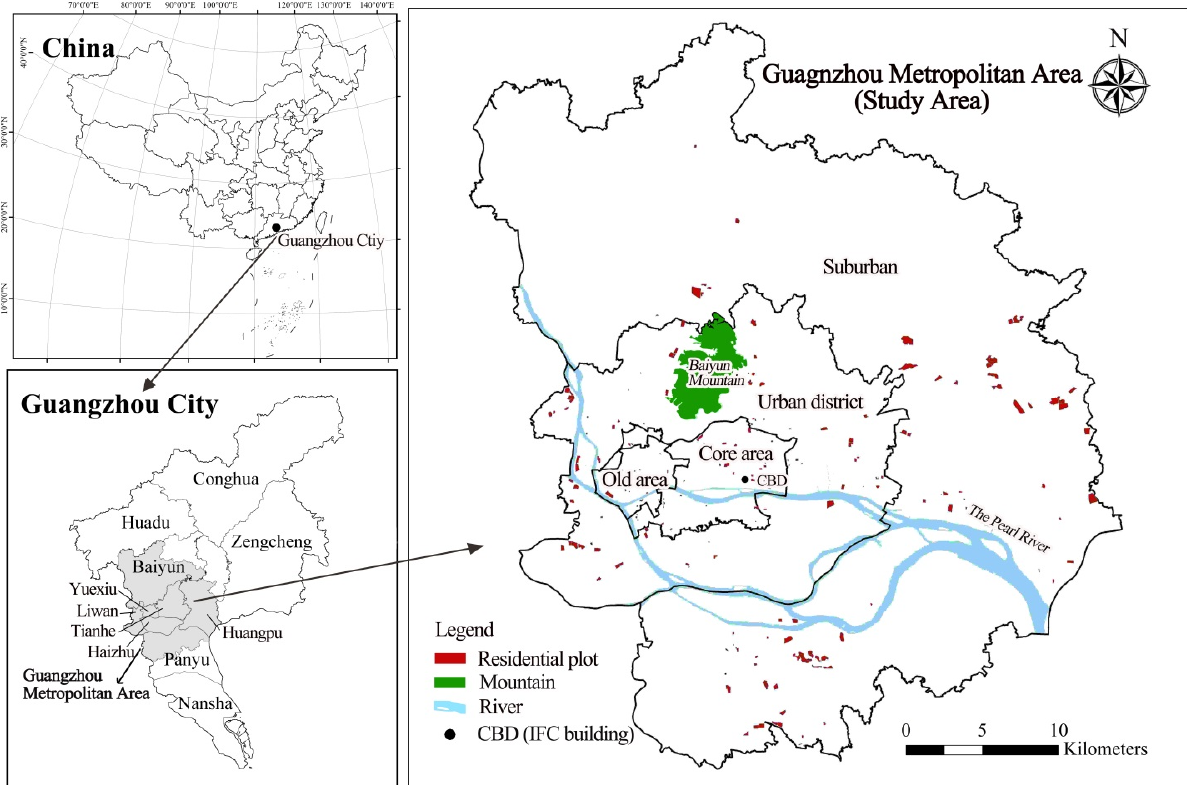
Figure 1. Taking the typical residential quarters newly built in 2010 as the basic research unit, there are 212 units in total, including 24 in old area, 37 in core area, 70 in urban district, and 81 in suburban.